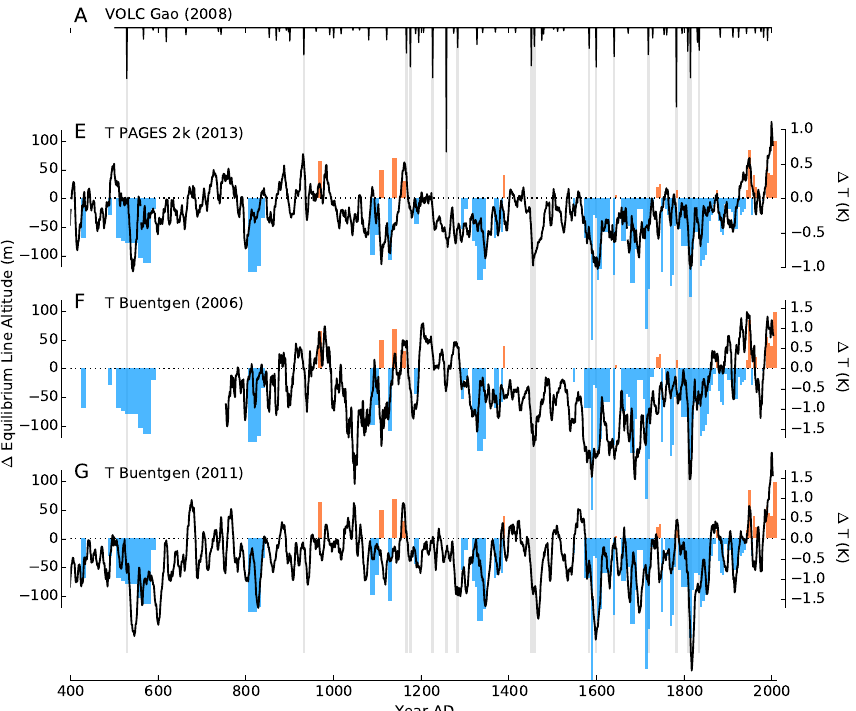
Fig. 4. ELA variation reconstruction for the time span 400–2010 compared to climate records from different proxies. (A) Northern Hemi- sphere stratospheric sulfate loading from explosive volcanism (Gao et al., 2008). (E) multi-proxy temperature reconstruction (PAGES 2k consortium, 2013). (F, G) temperature reconstructions from tree rings (Büntgen et al., 2006, 2011). All temperature curves are smoothed with a 7-year running